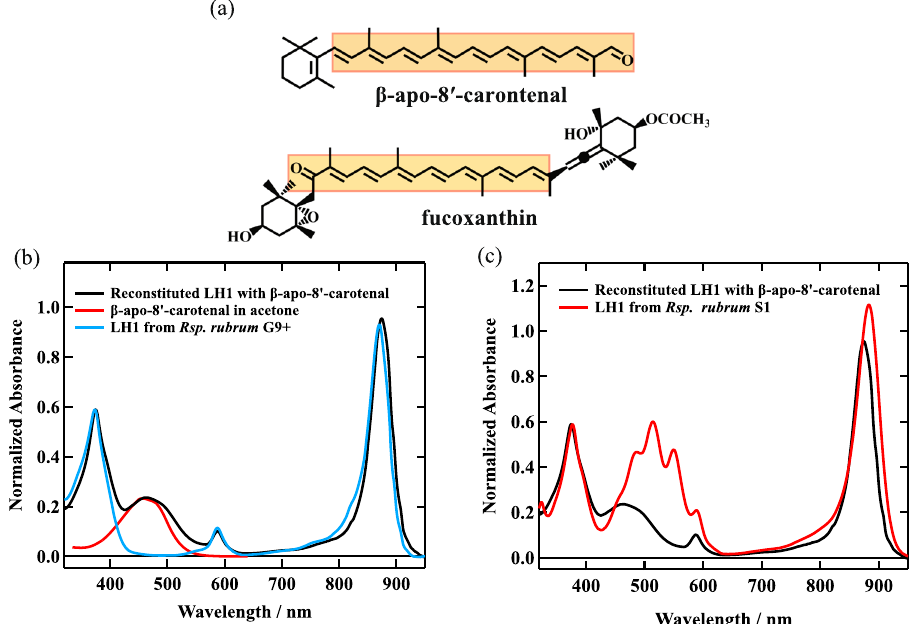
Fig. 2 Comparison of the steady-state absorption spectra. a Chemical structures of β -apo-8 ′ -carotenal and fucoxanthin. Conjugated polyene parts coupled with carbonyl group are highlighted with yellow color. b Steady-state absorption spectra of Re β apo in 20 mM Tris-HCl buffer (pH 8.0) + 0.58% β -OG (solid black line), β -apo-8 ′ -carotenal in acetone (solid red line), and the LH1 complex isolated from Rsp. rubrum strain G9 + in 50 mM phosphate buffer (pH 7.0) + 0.58% β -OG + 10 mM sodium ascorbate (solid blue line). c Steady-state absorption spectra of Re β apo in 20 mM Tris-HCl buffer (pH 8.0) + 0.58% β -OG (solid black line), and the LH1 complex isolated from Rsp. rubrum strain S1 in 50 mM phosphate buffer (pH 7.0) + 0.6% β -OG + 10 mM sodium ascorbate (solid red line). Absorption intensity is normalized at B880 maximum. All the measurements were carried out at room